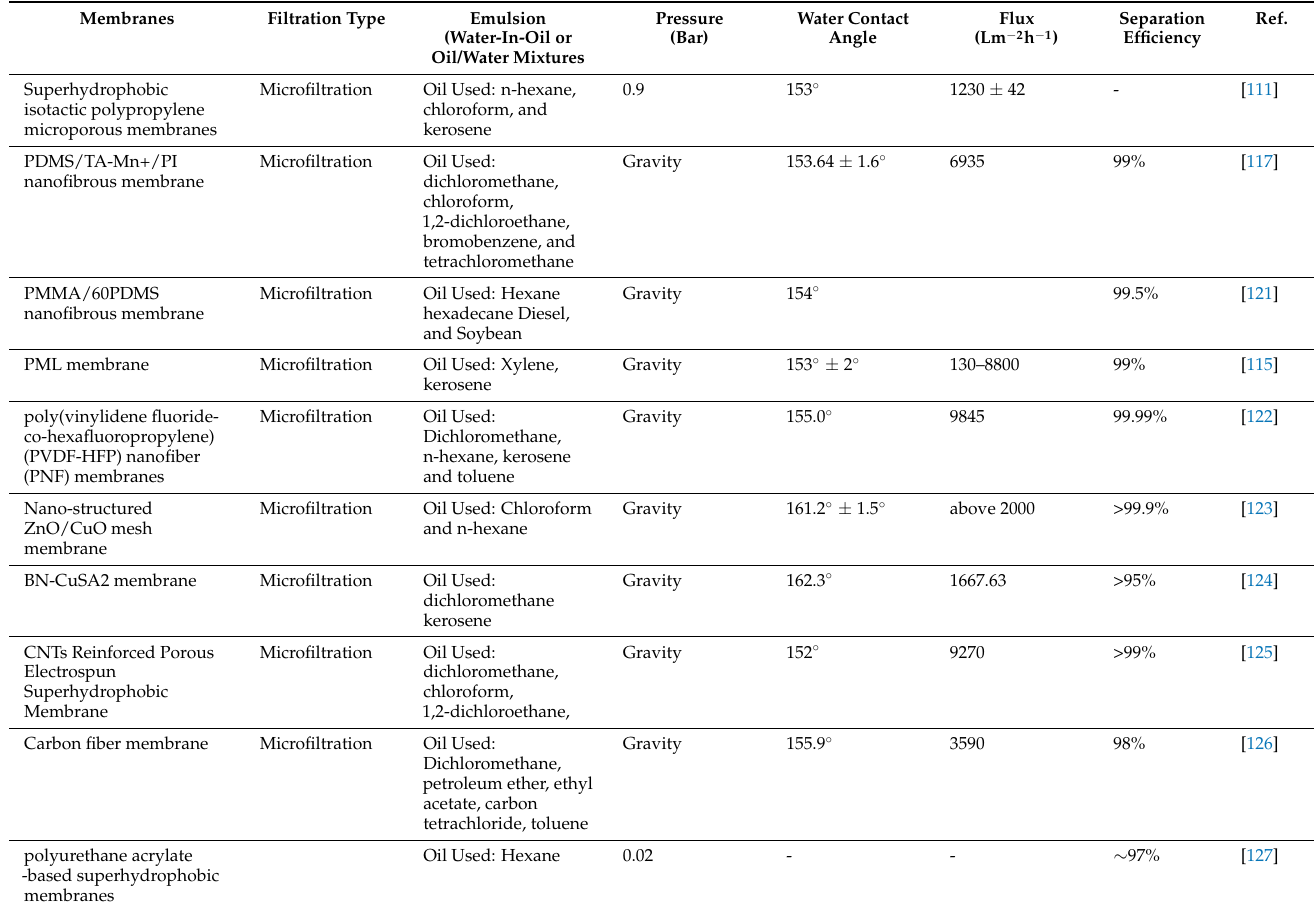
Table 1. Comparison of the performance of the Superhydrophobic membranes for oil/water